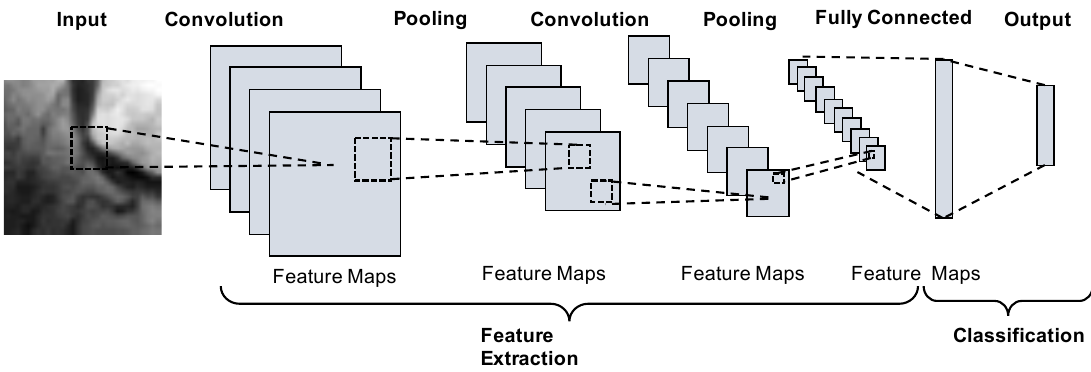
Figure 4. The architecture of a typical Convolutional Neural Network